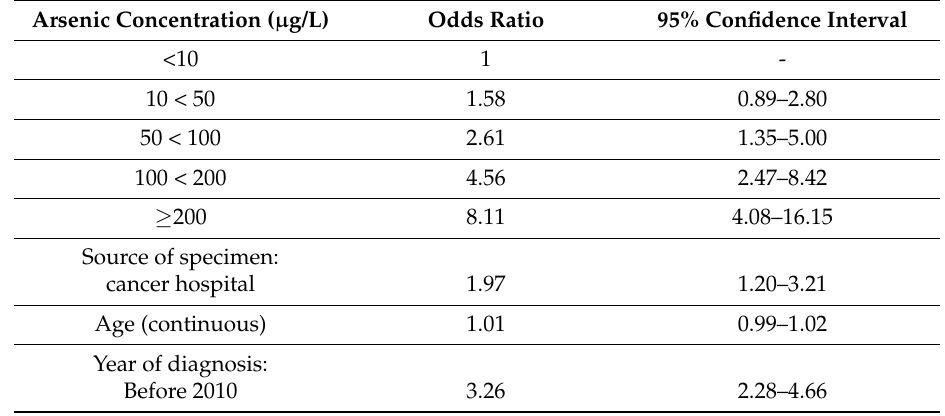
Table 5. Logistic regression for histological diagnosis of poorly differentiated squamous cell carcinoma, allowing for clustering within thana (N =